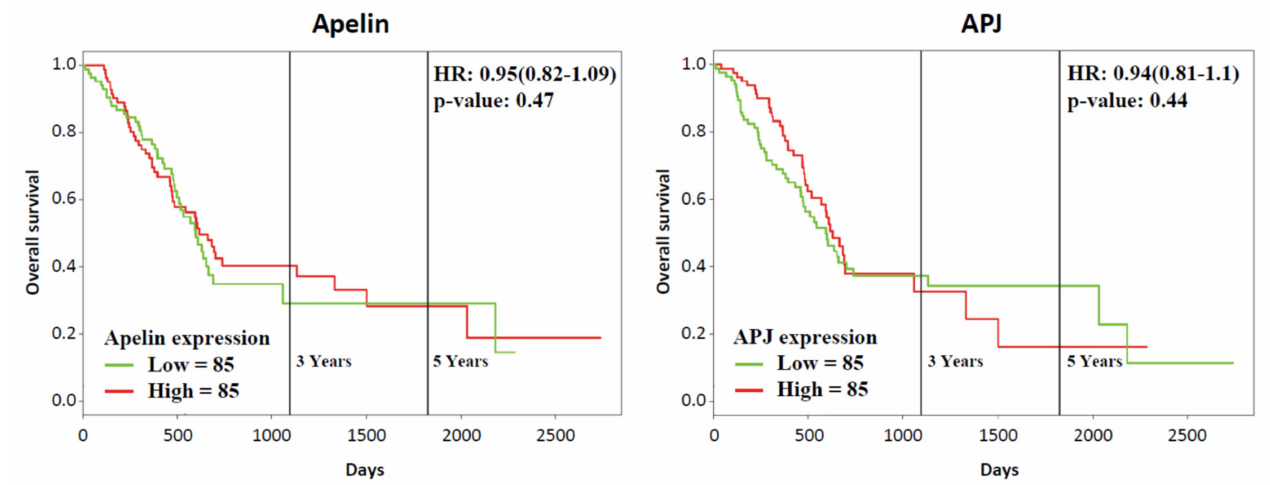
Figure A3. Overall survival for high and low Apelin or APJ mRNA expression in human pancreatic cancer. Kaplan–Meier survival curves for high versus low apelin ( left panel ) and APJ ( right panel ) mRNA expression in pancreatic adenocarcinoma were generated using an integrated database (TCGA cohort) (http://genomics.jefferson.edu/proggene/), (accessed on 9 July 2019). Overall survival for high (red) and low (green) Apelin or APJ expressing pancreatic cancer is compared across all